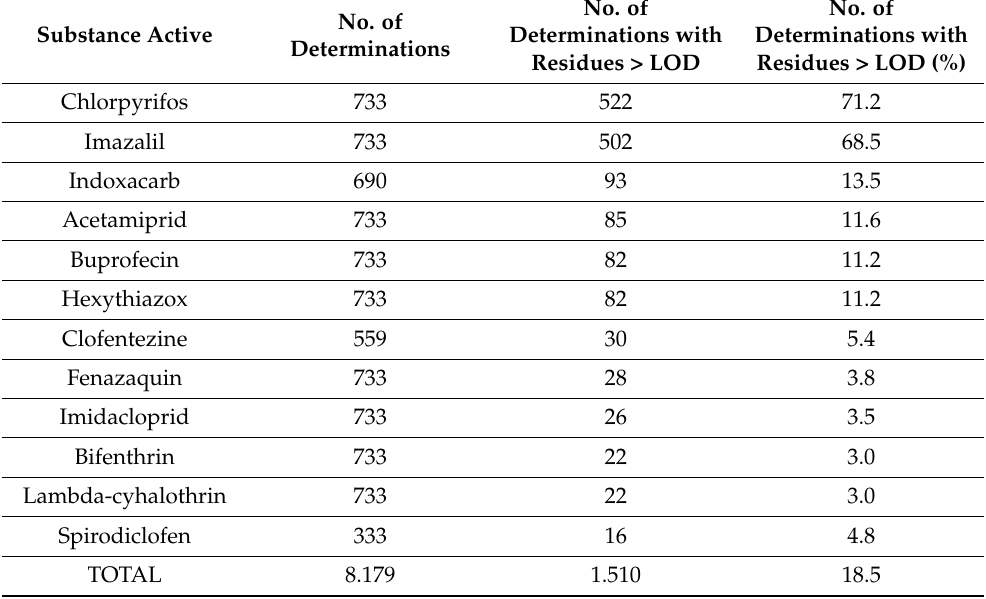
Table 8. List of the most frequent active